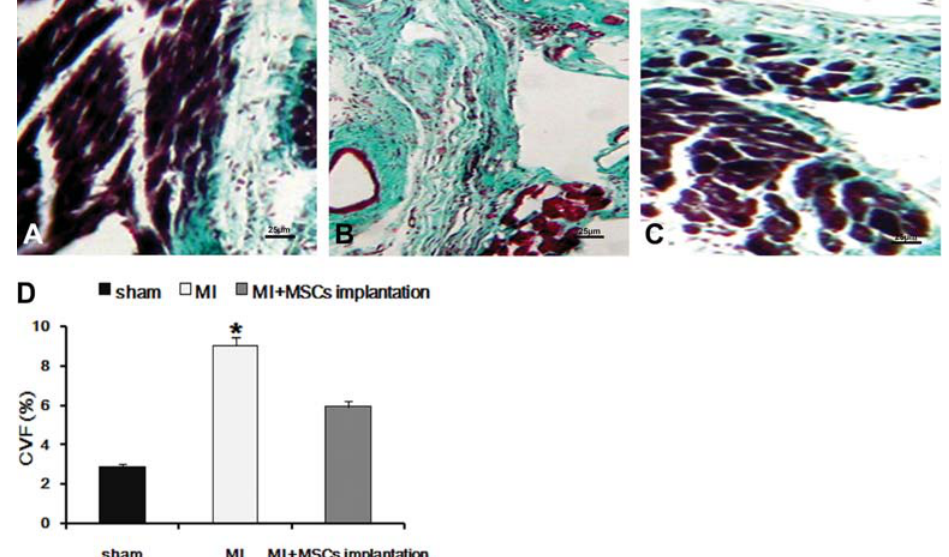
Figure 5. Masson staining results. A , sham operation group; B , after myocardial infarction, a scar area dyed green or blue appears in the control group; C , muscle cells dyed red can be observed between collagen fi bers in the group that received myocardial implantation of mesenchymal stem cells (MSCs) in the infarcted heart; D , myocardial collagen volume fraction (CVF) of different groups. MI: myocardial infarction. Magni fi cation bar: 25 m m. Data are reported as means ± SD. *P o 0.05 vs sham operation group (one-way